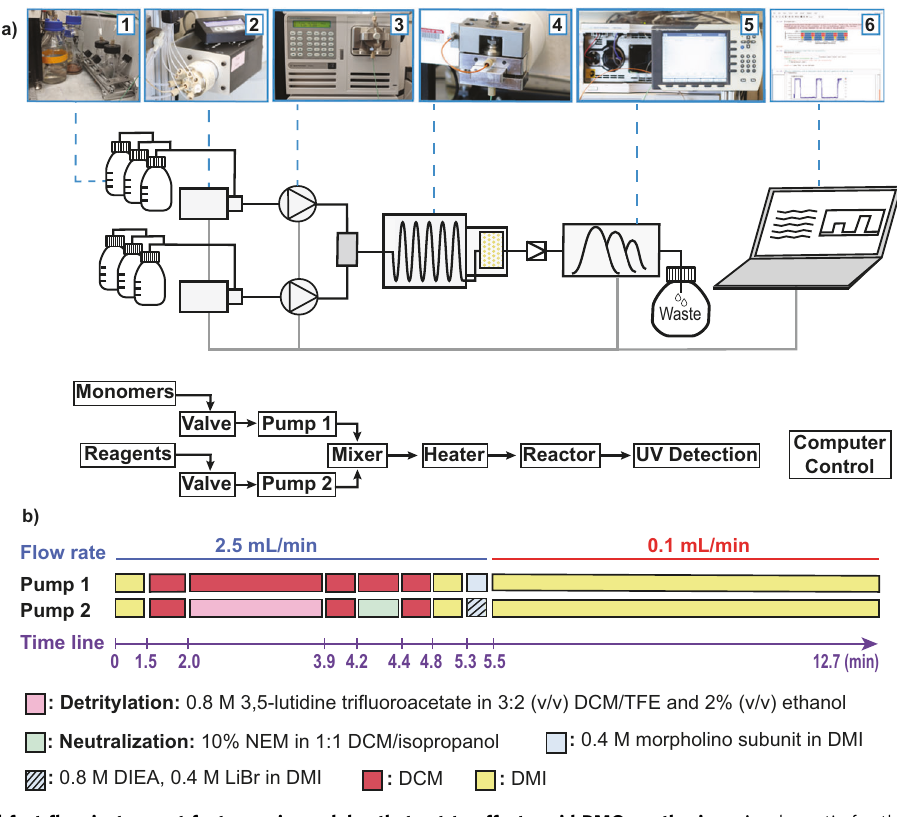
Fig. 3 The automated fast- fl ow instrument features six modules that act to effect rapid PMO synthesis. a A schematic for the fl ow path of the instrument is shown. Valves select the appropriate solutions from glass bottles under nitrogen pressure. Two HPLC pumps mix the reagents and fl ow them over a packed resin bed held at 90 °C. Ef fl uent cools as it exits the reactor and passes through a back-pressure regulator to an in-line UV – vis detector, where reaction progress is monitored. A computer running an automated Python script controls the valves and pumps throughout the synthesis, and tracks the instrument performance from the UV – vis detector. b The optimized protocol for PMO synthesis is shown. Instructions are delivered by the control program to the pumps and valves at each of the listed times. Bars represent activity of the two HPLC pumps, and colors indicate which reagents the valves are open to. Reagent stocks are prepared in double the concentration that is intended to hit the resin. Dilution from the second pump prepares the correct concentrations upon